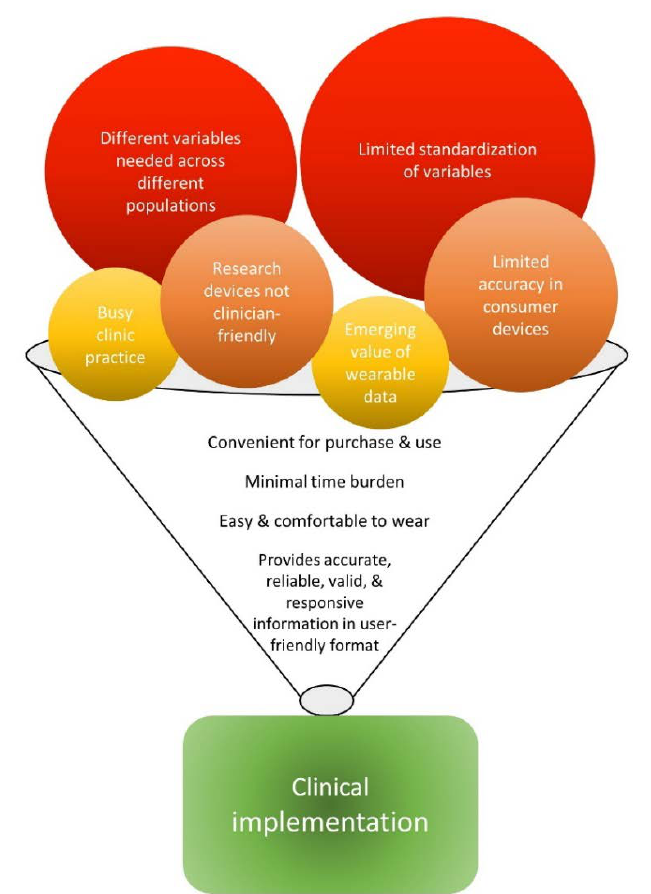
Figure 3. Barriers and benchmarks for implementation of wearable sensor technology into routine clinical rehabilitation practice. The warmest colors and largest circles indicate barriers that will take more work to overcome. Once the barriers are su ffi ciently reduced, then widespread clinical implementation (green rectangle) will be